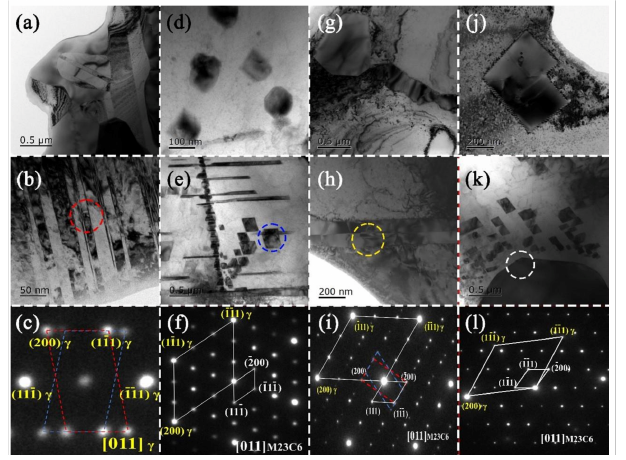
Figure 6. TEM images of stainless steel samples: ( a ) twins in heat-treated sample A; ( b , c ) nanotwins and their SAED patterns in sample A, respectively; ( d ) carbide precipitations in sample A; ( e , f ) carbides and their SAED patterns in sample C, respectively; ( g ) grain-boundary carbides in sample C; ( h , i ) carbide twins and their SAED patterns in sample C, respectively; ( j ) regular carbide in sample D; ( k , l ) large carbides and their SAED patterns in sample F,